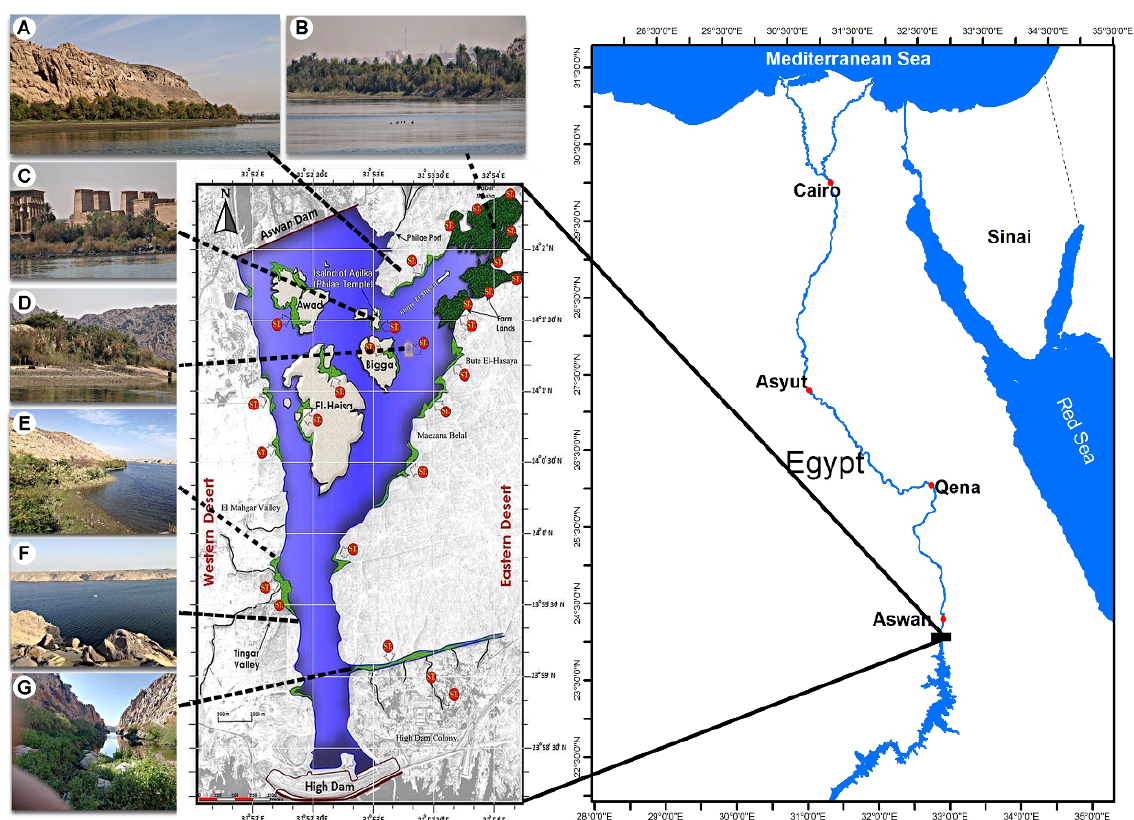
Figure 7. Location map of the study area of the Aswan Reservoir showing the sampling sites. Photos show the landscape of some locations: ( A ) Philae Port, ( B ) El Shallal area, ( C ) Agilkia, ( D ) Bigga Island, ( E ) El Mahgar Valley, ( F ) Tingar, ( G ) High Dam Colony.